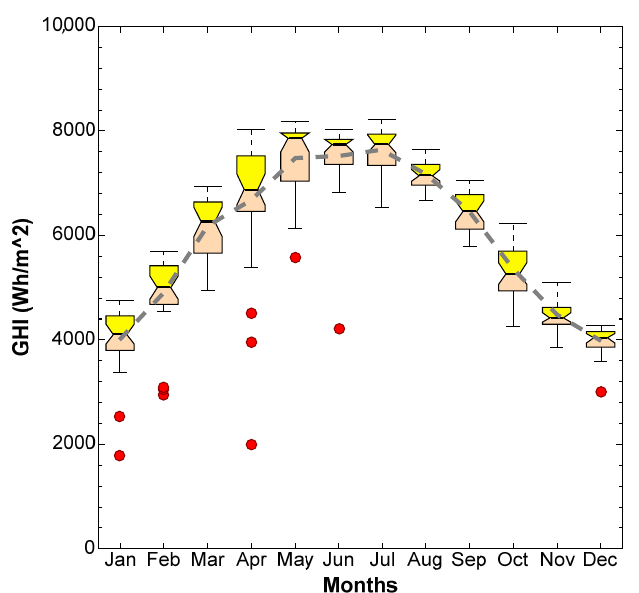
Figure A1. Notched boxplots show the daily variability of GHI for each month; the dashed line shows the mean values.